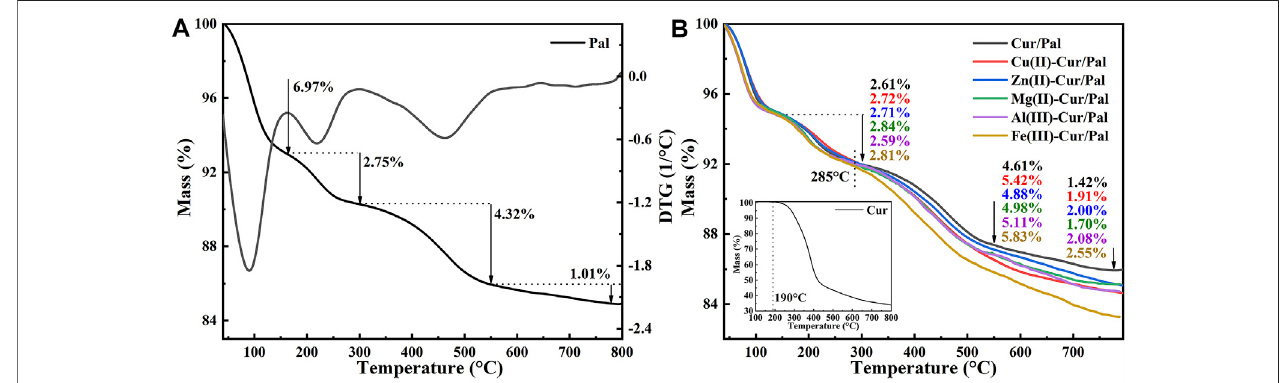
FIGURE 6 | TGA curves of (A) Pal, Cur (the inset), (B) Cur/Pal and metal ions-Cur/Pal hybrid materials.